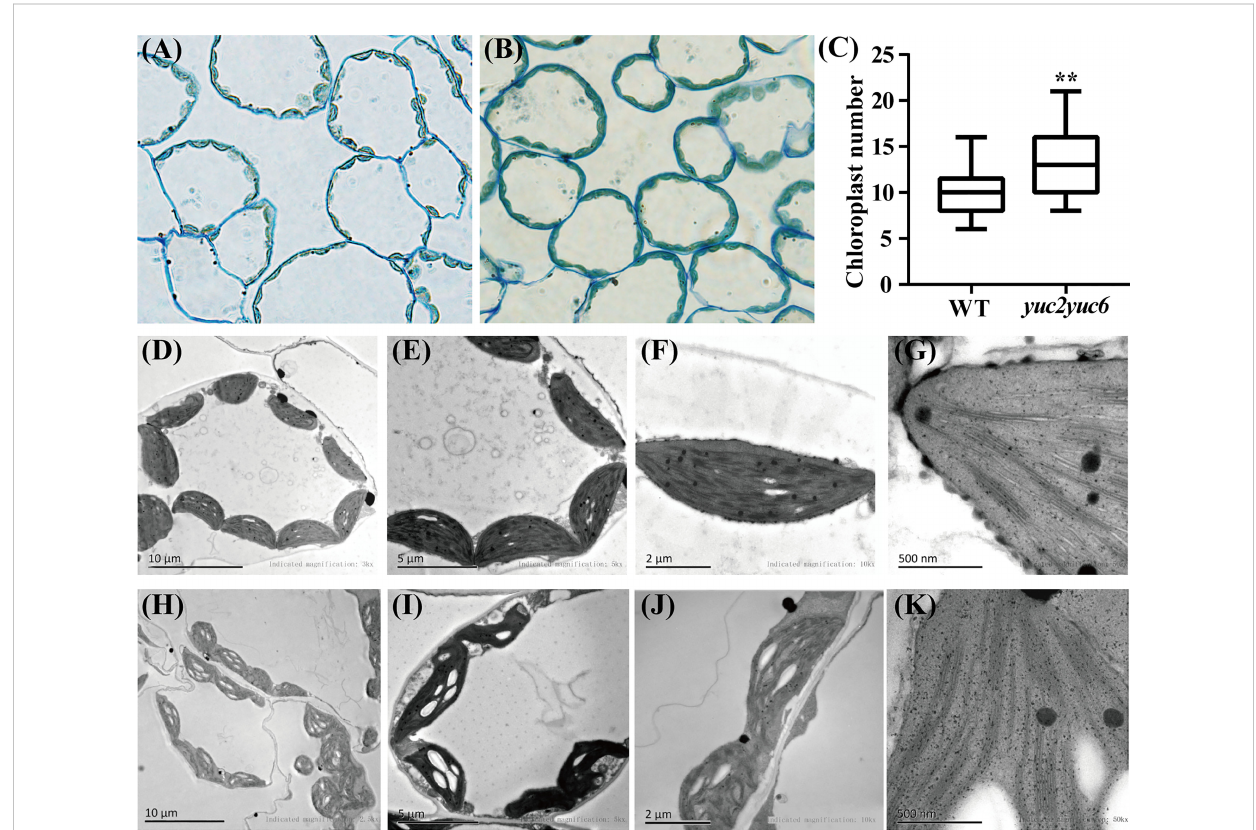
FIGURE 2 Chloroplast morphology of mesophyll cells in rosette leaves of WT and yuc2 yuc6 . (A) Mesophyll cells of WT. (B) Mesophyll cells of yuc2 yuc6 . (C) Chloroplast numbers of mesophyll cells. (D-G) Chloroplast ultrastructure of WT. (H-K) Chloroplast ultrastructure of yuc2 yuc6 . ** represents p value <